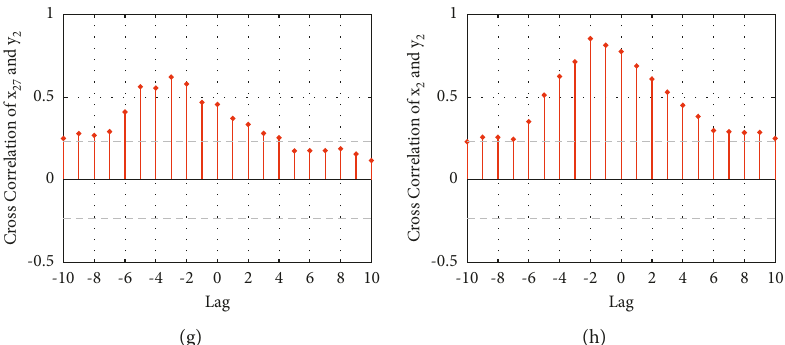
Figure 3: Cross-correlation coefficients between the number of daily confirmed cases of COVID-19 in Beijing from 11 June to 3 September, 2020 and the daily number of media reports of websites (a) China.com.cn, (b) people.com.cn, (c) xinhuanet.com, (d) news.sina.com.cn, (e) cyol.com, (f) chinanews.com, and (g) gmw.cn. (h) Cross-correlation coefficients between the average daily number of media reports and the number of daily confirmed